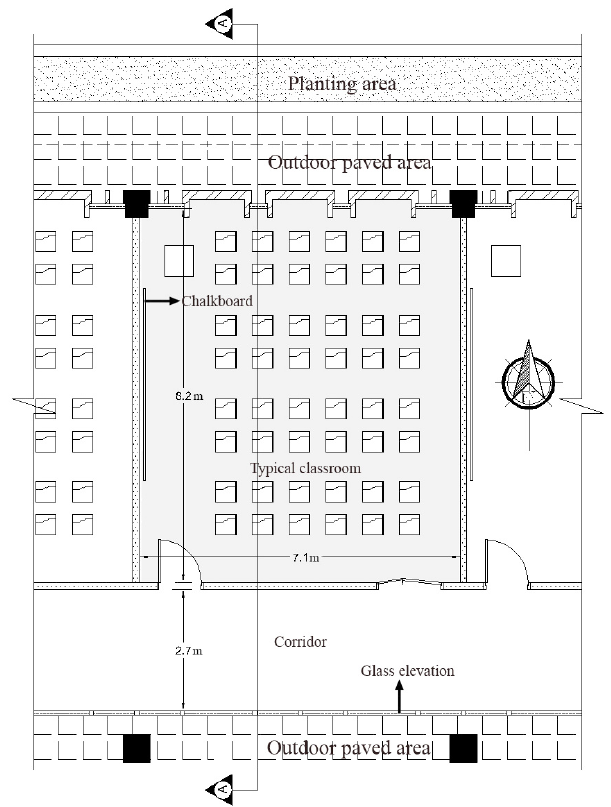
Figure 1. Plan of a typical classroom at Jordan University of Science and Technology (JUST) showing seating layout, and windows’ and chalkboard locations.